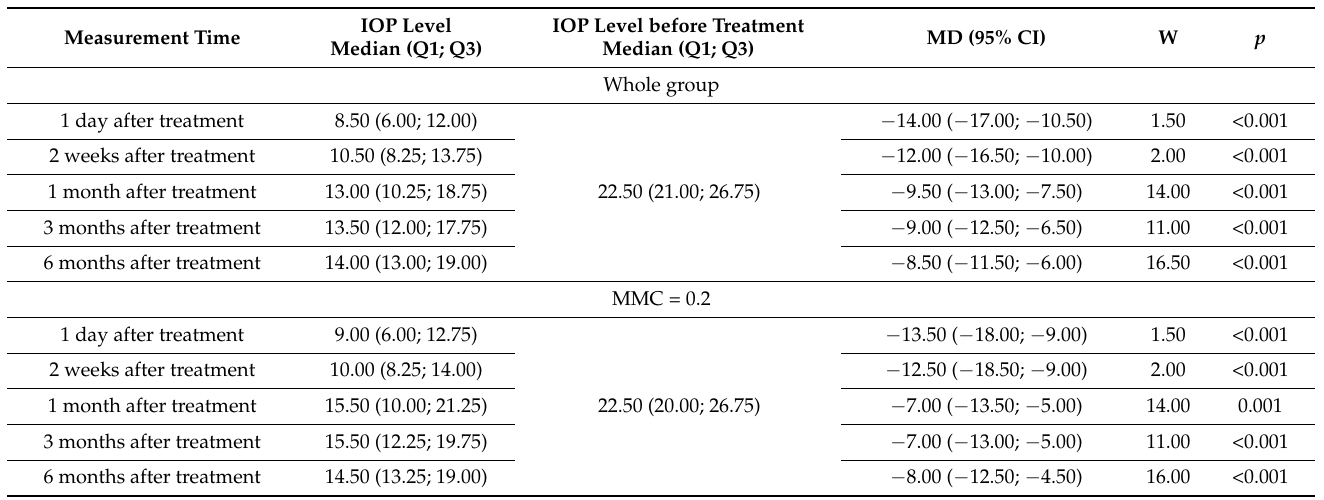
Table 3. Comparison between IOP level before treatment and IOP level 1 day, 2 weeks, 1 month, 3 months, and 6 months after treatment (in the whole group, in the group of people with MMC = 0.5 mg/mL and MMC = 0.2